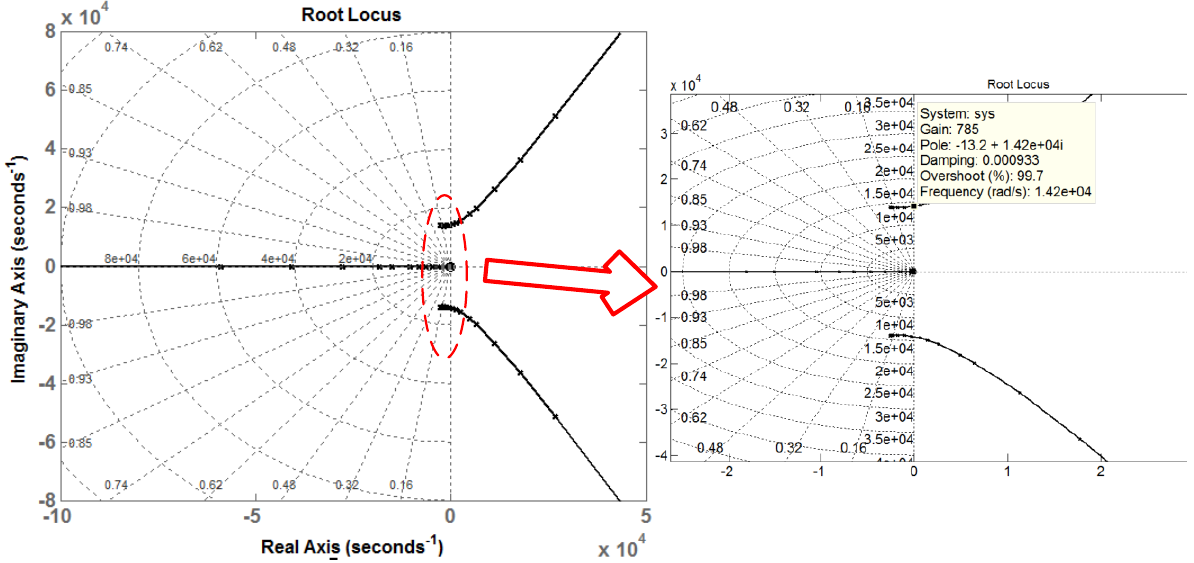
while other parameters are 𝑖1